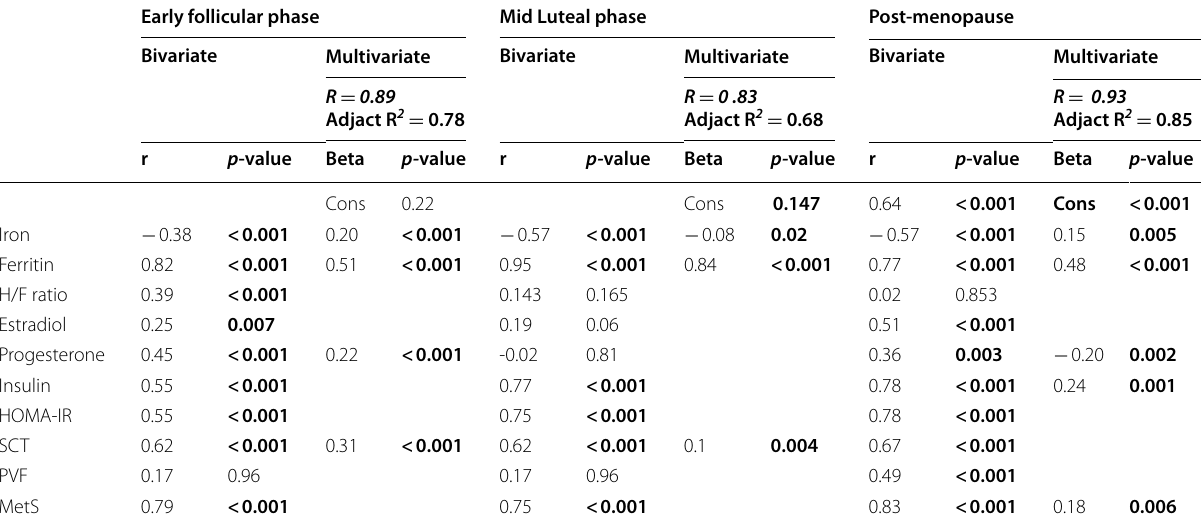
H / F Ratio hepcidin/ferritin ratio, HOMA - IR Homeostatic model assessment of insulin resistance, SCF Subcutaneous fat thickness, PVF Peritoneal visceral fat thickness, PVF , MetS Metabolic